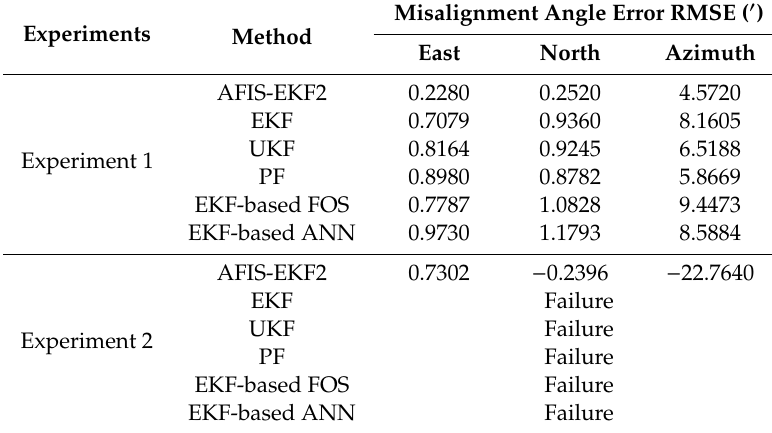
Table 6. Comparison of alignment experiment results of AFIS–EKF2, EKF, unscented Kalman filter (UKF), particle filter (PF), and fast orthogonal search